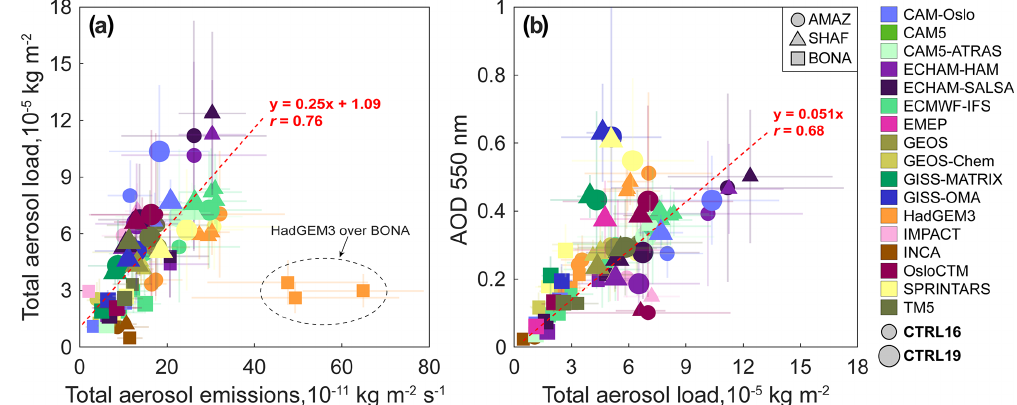
Figure 9. The dependence of total aerosol load on total aerosol emissions (a) and dependence of AOD on aerosol load (b) , indicating the aerosol lifetime and MECs, respectively. The data are average values for all the fire seasons based on the raw model output without collocation, and the light-colored error bars indicate the corresponding temporal variations (as standard deviation). The color, shape, and size of dots indicate different models, three fire regions, and two AeroCom control experiments, respectively. The dashed red lines show the linear trends, with a regression function and correlation coefficients ( r ) also shown. Note that some CTRL16 models provide data for different years (2006, 2008, and 2010), which are illustrated